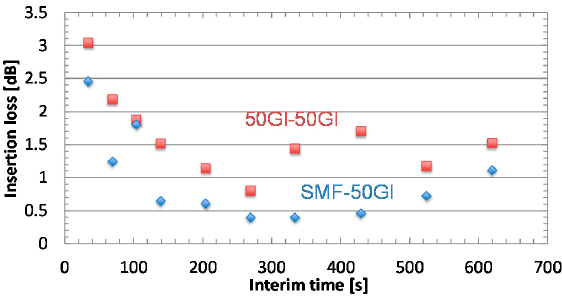
Figure 13. Interim time dependence of the insertion loss of the 5-cm long polymer waveguide. Appl. Sci. 2017 , 7 , 940